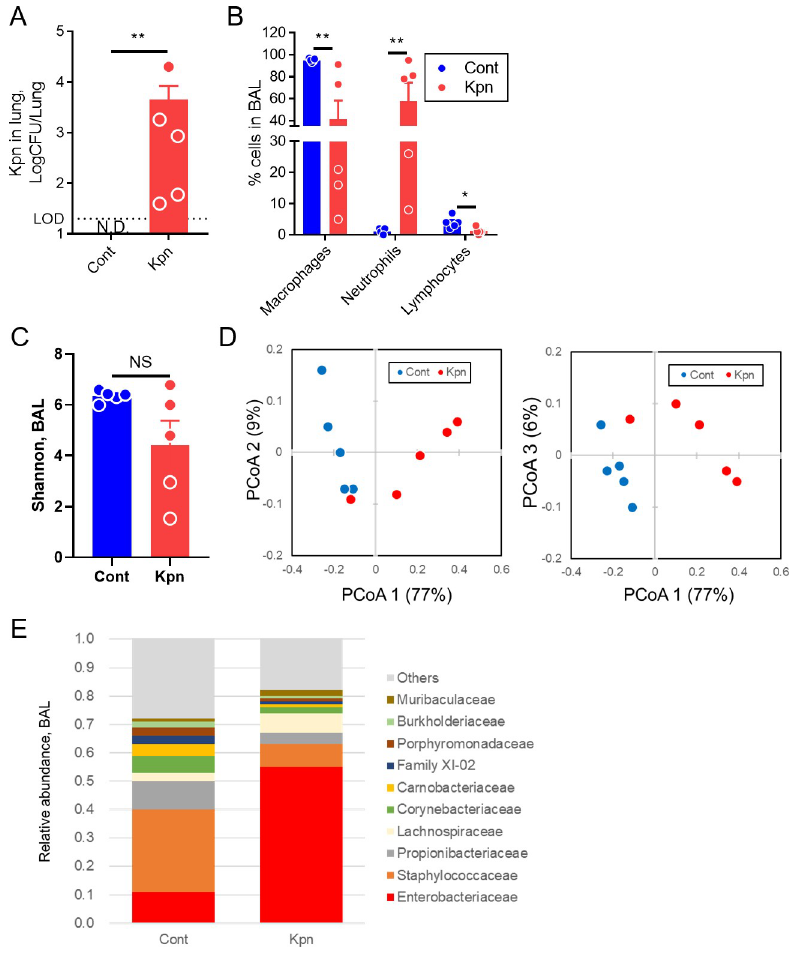
Fig 1. Microbiological characteristics of the lungs after K . pneumoniae infection. Mice were intratracheally infected with K . pneumoniae (Kpn) or inoculated with phosphate-buffered saline as the control (Cont). Five mice were used for each group. (A) The number of K . pneumoniae cells in lungs at 24 h after inoculation. (B) The population of cells in bronchoalveolar lavage (BAL) fluid. (C) Alpha diversity of BAL fluid analyzed by Shannon index. (D) Weighted UniFrac with three principal coordinate components. The number in parenthesis represents the contribution of each component. (E) Taxonomic distribution at the family level. Only families with 1% or more abundance in both groups are presented. Data represent two independent experiments. Filled circles represent individual mice, and each bar represents the mean ± SEM. LOD, limit of detection. N.D., not detected. PCoA, principal coordinate analysis. �� , p < 0.01. � , p < 0.05. NS, not